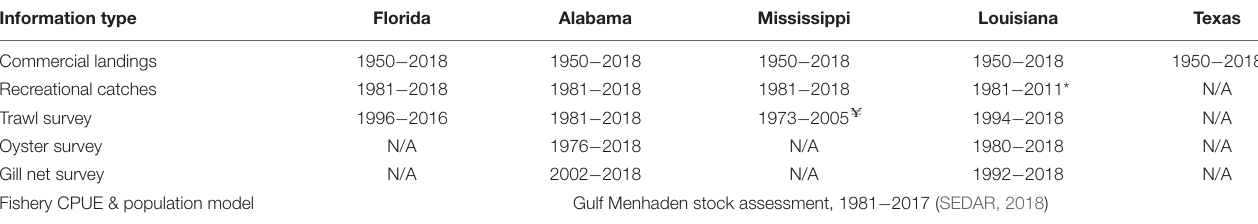
TABLE 1 | Data sources used to evaluate the status of living resources in coastal and nearshore areas in the northern GoM affected by the Deepwater Horizon oil spill. Information